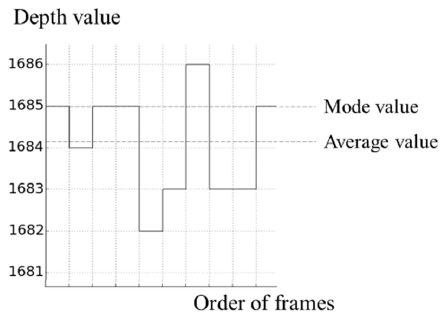
Figure 4. Methods for obtaining depth value of virtual touch panel.